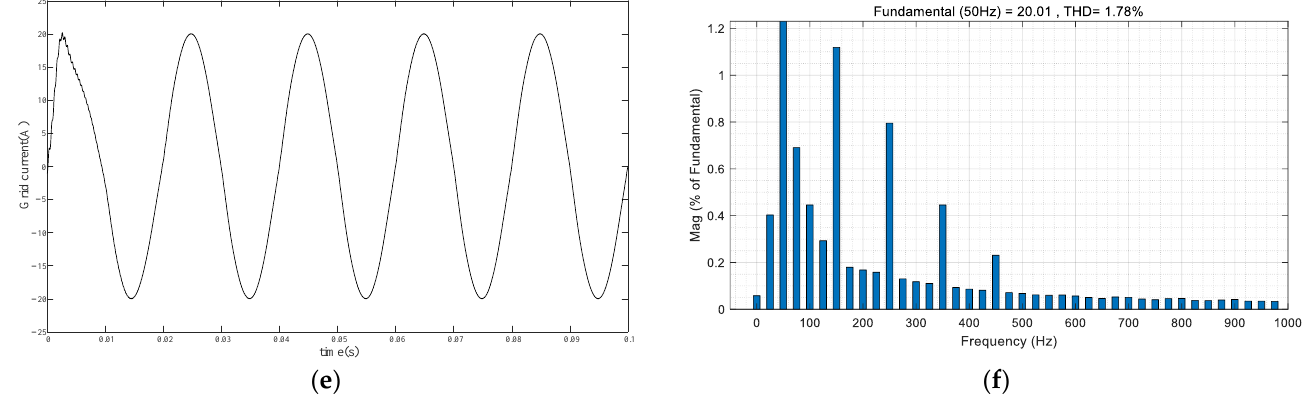
Figure 11. Simulation results under grid background harmonics. ( a ) Grid current under conven- tional control; ( b ) THD analysis of grid current under conventional control ; ( c ) Grid current under ADRC + PBC; ( d ) THD analysis of grid current under ADRC + PBC; ( e ) Grid current under FUZZY - ADRC + PBC; ( f ) THD analysis of grid current under FUZZY - ADRC + PBC. Table 5. THD analysis of grid - connected current under the condition of grid background harmon- ics.